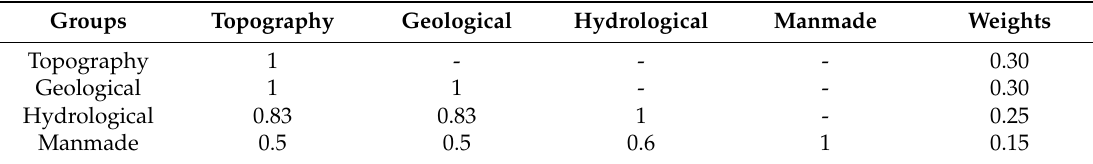
Table 2. The pairwise comparison matrix of the hybrid spatial multi-criteria evaluation (SMCE) groups and the resulting weights.